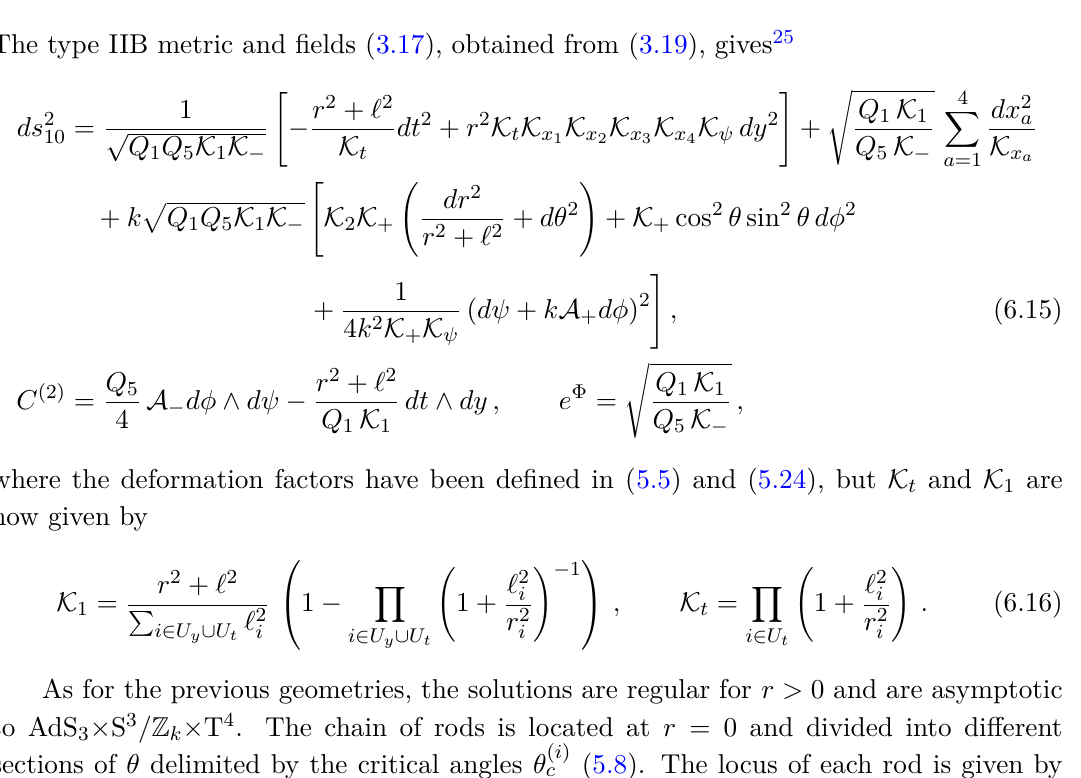
Figure 18 . Schematic description of the spacetime induced by a chain of 5 rods, inducing a horizon or the degeneracy of either the S 1 ( y ) or a T 4 direction or the Hopf angle of the S 3 . On the left-hand side, we depict the overall geometry in terms of r . On the right-hand side, we describe the behavior of the S 3 , S 1 , and T 4 at r = 0 and as a function of θ